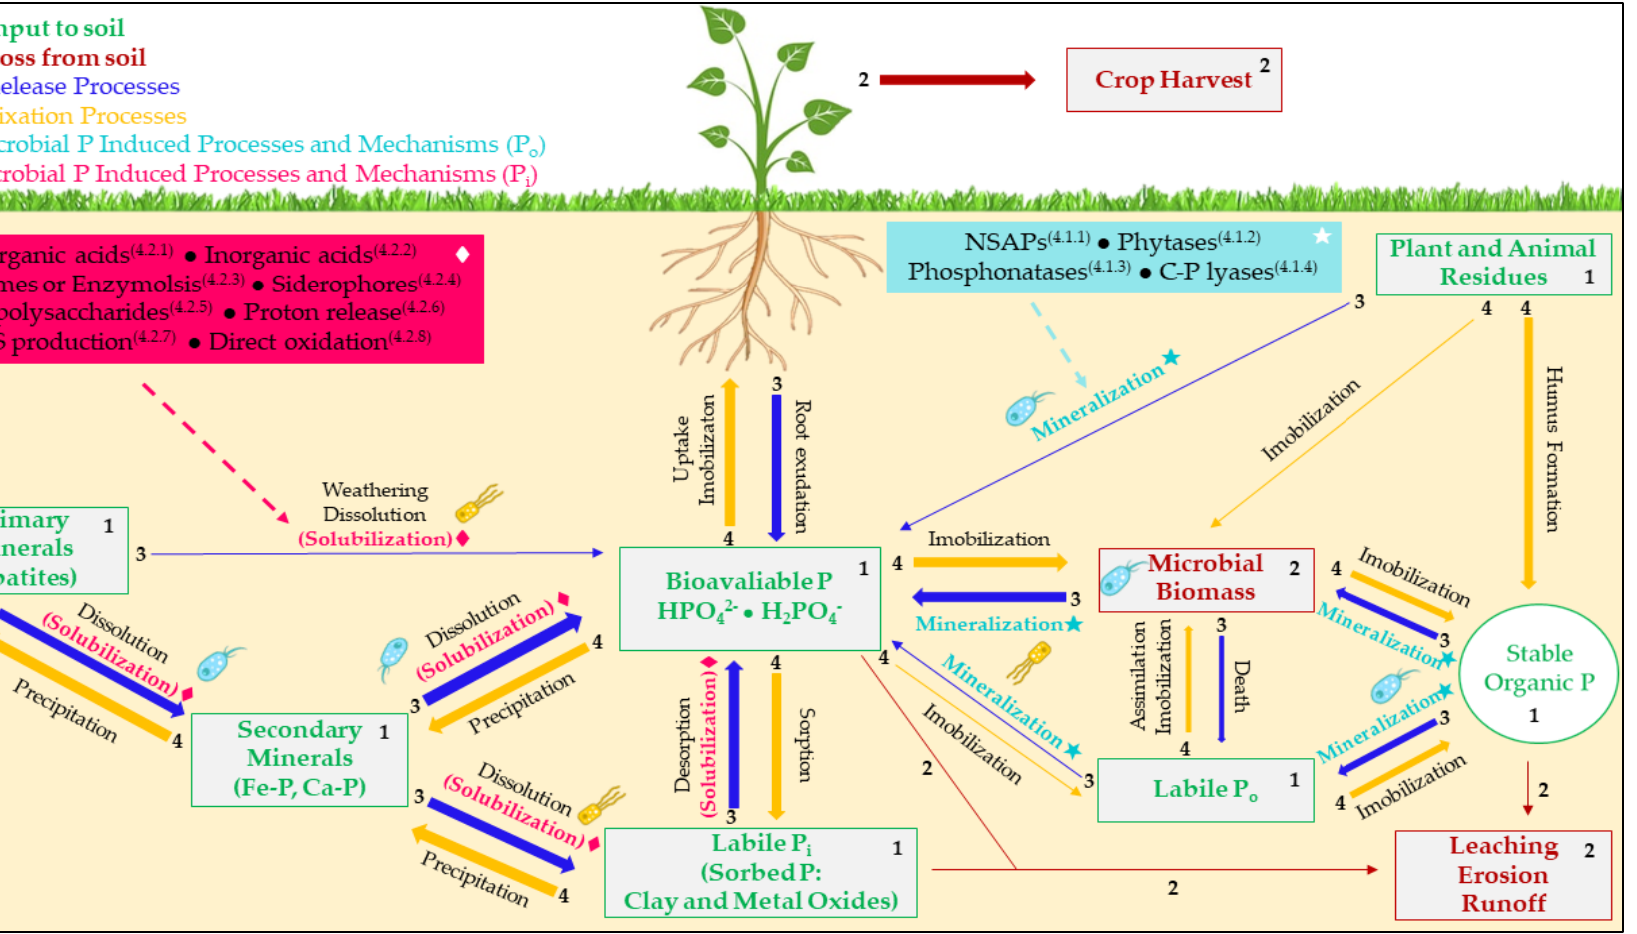
Figure 1. Phosphorus cycle and nutrient mobilization. The numbers and symbols at the base of the arrows are related to the P mobilization process described in the heading of the figure. The numbers related to the mechanisms correspond to the topics in which they are explained. NSAPs (4.1.1), phytases (4.1.2), phosphonatases (4.1.3), C–P lyases (4.1.4), organic acids (4.2.1), inorganic acids (4.2.2), enzymes or enzymolysis (4.2.3), siderophores (4.2.4), exopolysaccharides (4.2.5), proton release (4.2.6), H 2 S production (4.2.7), and direct oxidation